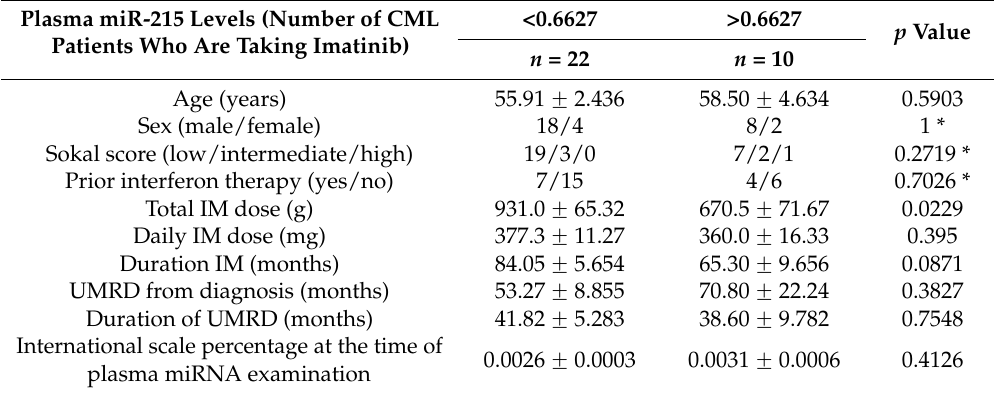
Table 1. Clinico-hematologic characteristics of chronic myeloid leukemia (CML) patients under imatinib therapy with or without down-regulation of plasma miR-215